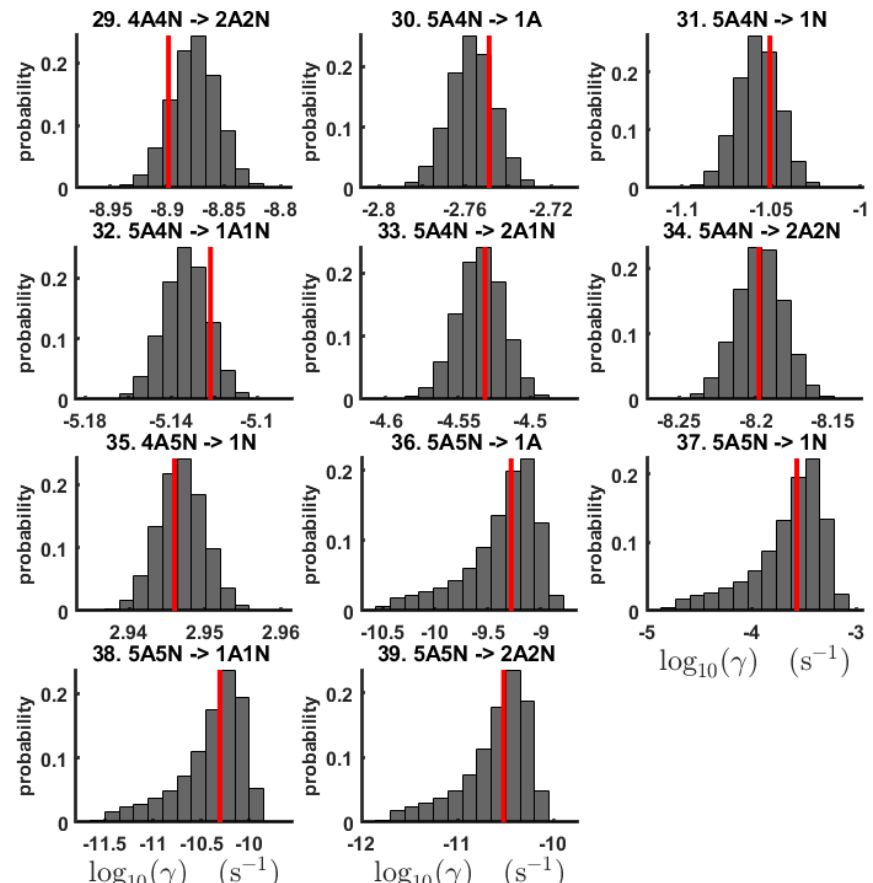
Figure D7. One-dimensional marginal distributions (for parameter indexes ranging from 29 to 39) of the base 10 logarithm of the evaporation rates (units given in s − 1 ) at temperature 278K obtained from a posterior distribution of thermodynamic parameters (cluster formation enthalpies and entropies) determined from steady-state cluster concentration measured at temperatures 278 and 292K. Red lines denote the baseline values from Olenius et al. (2013b) used to generate the synthetic data. The notation xAyN corresponds to a cluster with x sulfuric acid and y ammonia